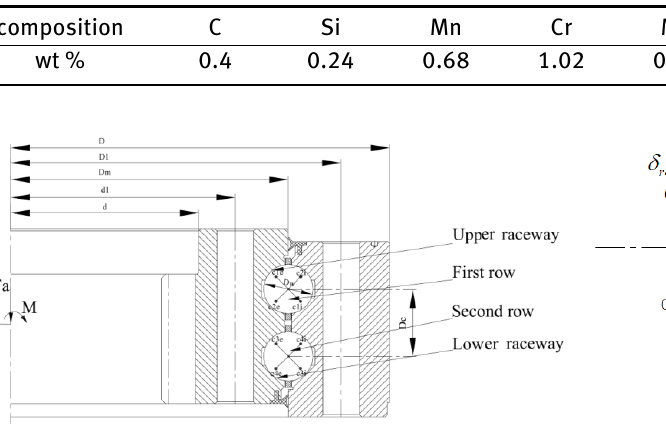
Figure 1: External load and topology of the slewing bearing Figure 2: Position of groove curvature center after loading